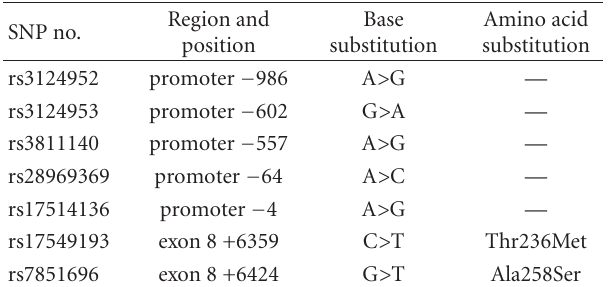
Table 2: Potentially important polymorphisms in the FCN2 gene. SNP